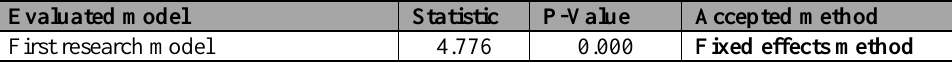
Table 7. Chow test results for the first research model